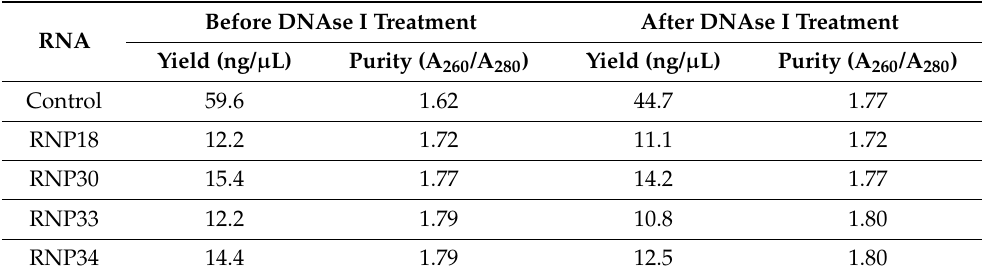
Table 2. Yield and purity of RNAs extracted from transfected protoplasts of stevia. RNA